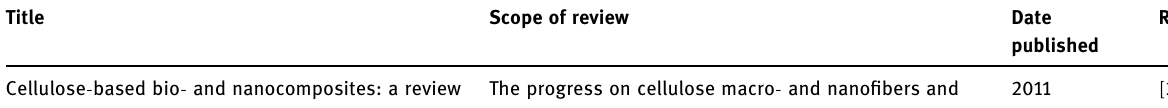
Table 1: Previously published reviews on biorenewable nanocomposites for sustainable